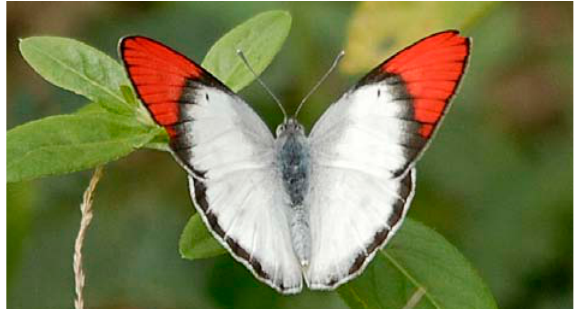
Image 6. Crimson Tip Colotis danae